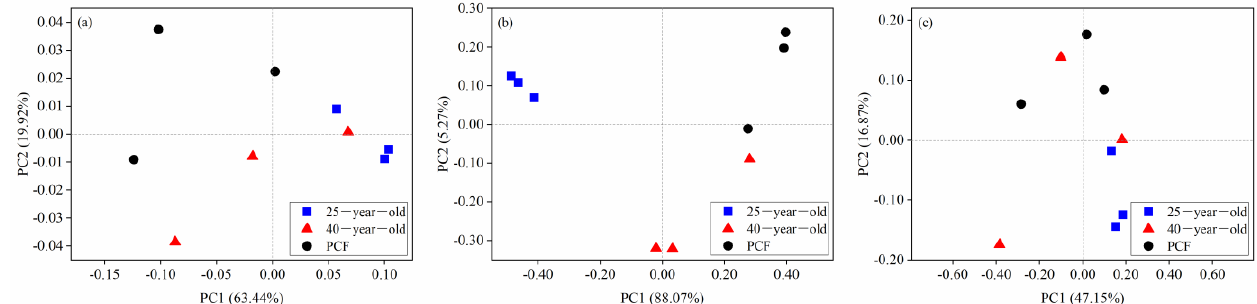
Figure 3. Principal coordinate analysis (PCoA) of the functional patterns of bacterial ( a ), fungal ( b ) and archaeal ( c ) communities across the three stands at the module level of KEGG. 25-year-old, 40-year-old and PCF represent the 25-year- old P. rubescens plantation, 40-year-old P. rubescens plantation and primeval coniferous forest, respectively. Table 5. Functional α -diversity of the microbial community in the three stands at the module level Table 6. Functional differences of microbial community among three stands at the module level of KEGG. Bacteria